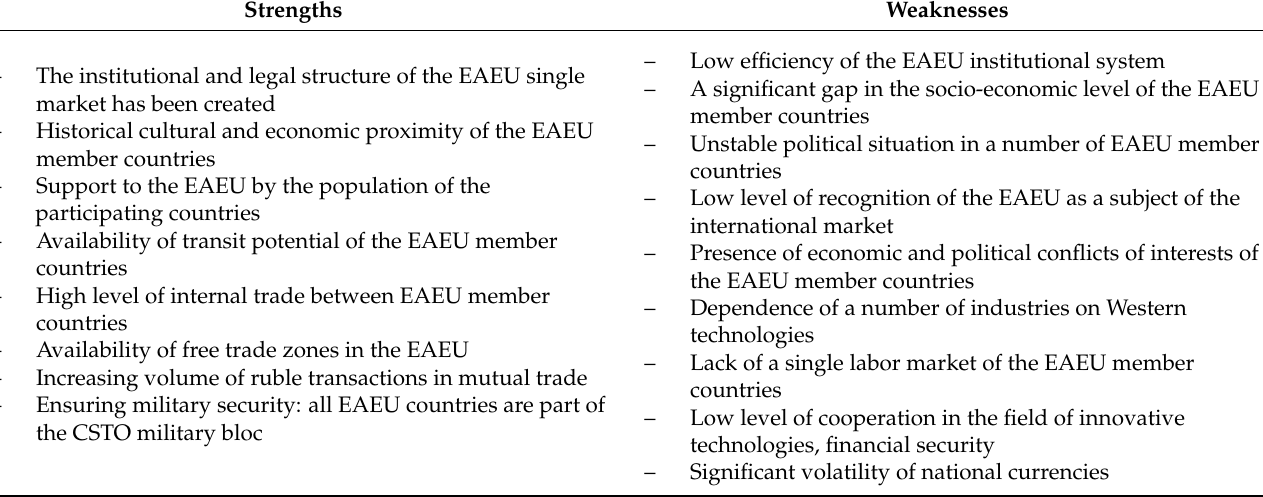
Table 4. SWOT analysis of the